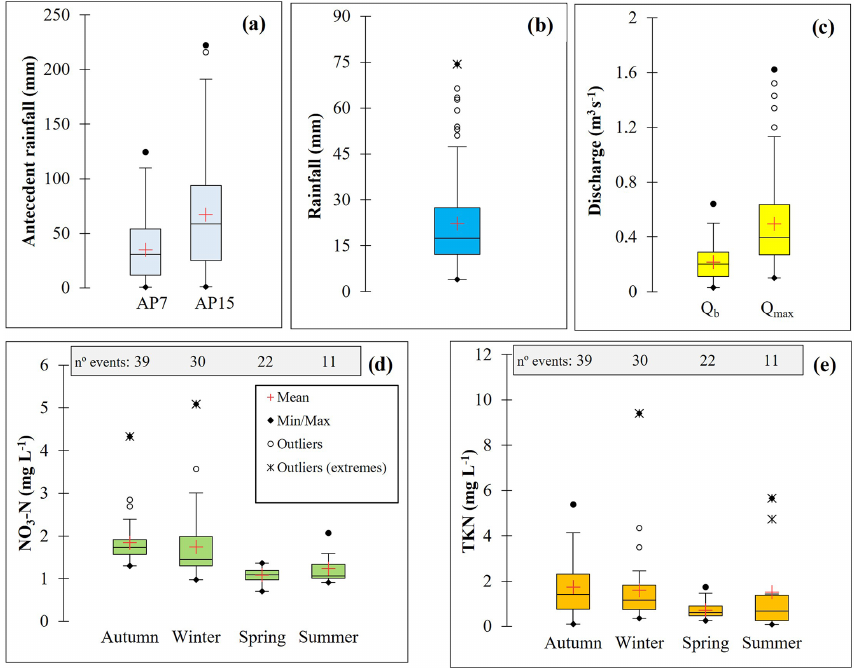
Figure 4. Box plot summarizing the characteristics of the events. (a) Antecedent rainfall. (b) Rainfall amount. (c) Discharge. (d) NO 3 concentrations (NO 3 -N). (e) TKN concentrations. The box shows the interquartile range (IQR), which is defined as the difference between the third and the first quartile. The horizontal line within the box shows the median. The whiskers shown the 1.5 times IQR beyond the box. The outliers are values between 1.5 and 3 times the IQR, which is larger than third quartile, or values between 1.5 and 3 times the IQR, which is lower than the first quartile. The extreme outliers show values 3 times the IQR, which is larger than third quartile, or 3 times the IQR, which is lower than the first